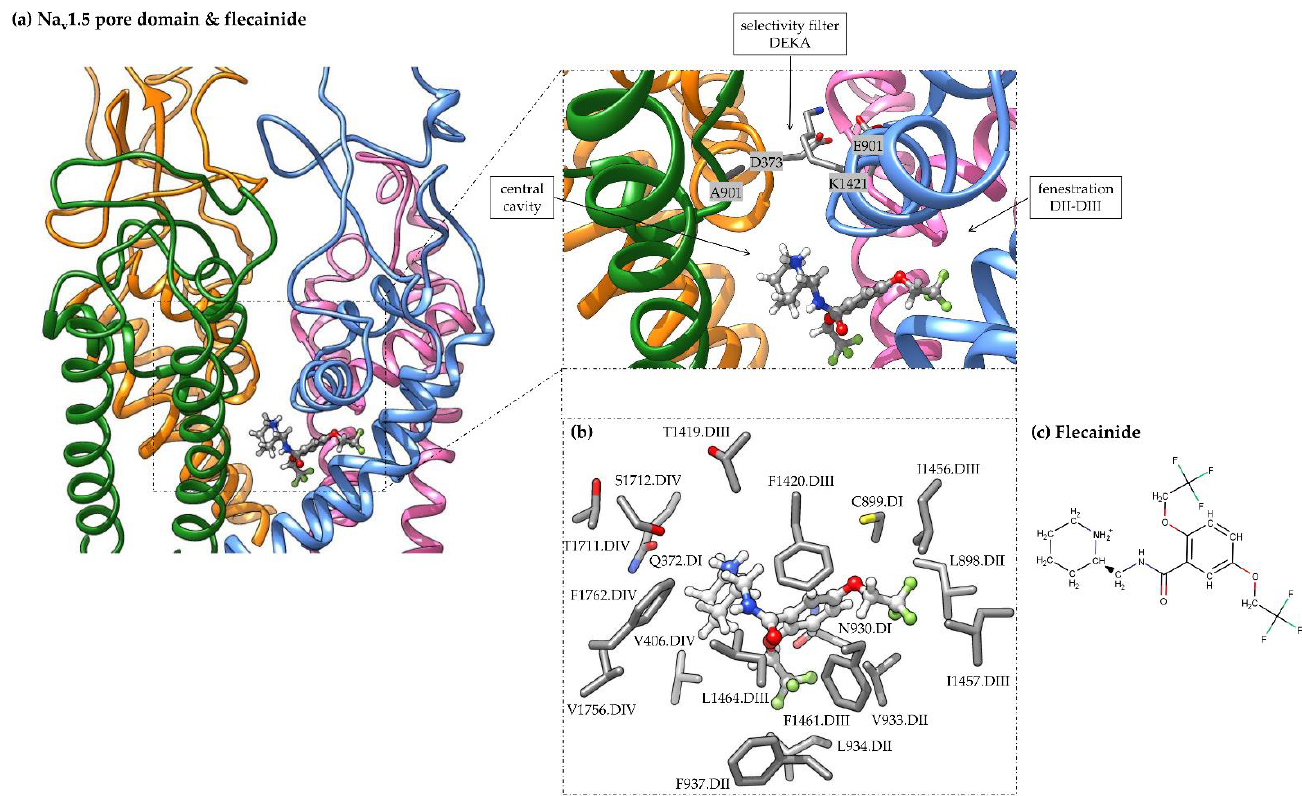
Figure 3. Representation of flecainide binding mode in Na v 1.5 channel . ( a ) Ribbon representation of Na v 1.5 pore domain; each domain is shown in a different color: orange (DI), pink (DII), blue (DIII) and green (DIV), and flecainide bound in the inner cavity is depicted in ball and sticks. Residues forming the selectivity filter are labeled and indicated in gray boxes. ( b ) Side-chain representation of residues in contact with flecainide (distance ≤ 5 Å ) having a frequency of interaction ≥ 70% along MD simulations. Residue names and numbers are indicated. The tertiary structure used corresponds to a frame from the holo MD trajectories. ( c ) Flecainide representation in 2D format. Flecainide and residues are colored per element with carbon atoms in dark gray, oxygen atoms in red, nitrogen atoms in blue, sulfur atoms in yellow, hydrogens in light gray and fluorine in green.